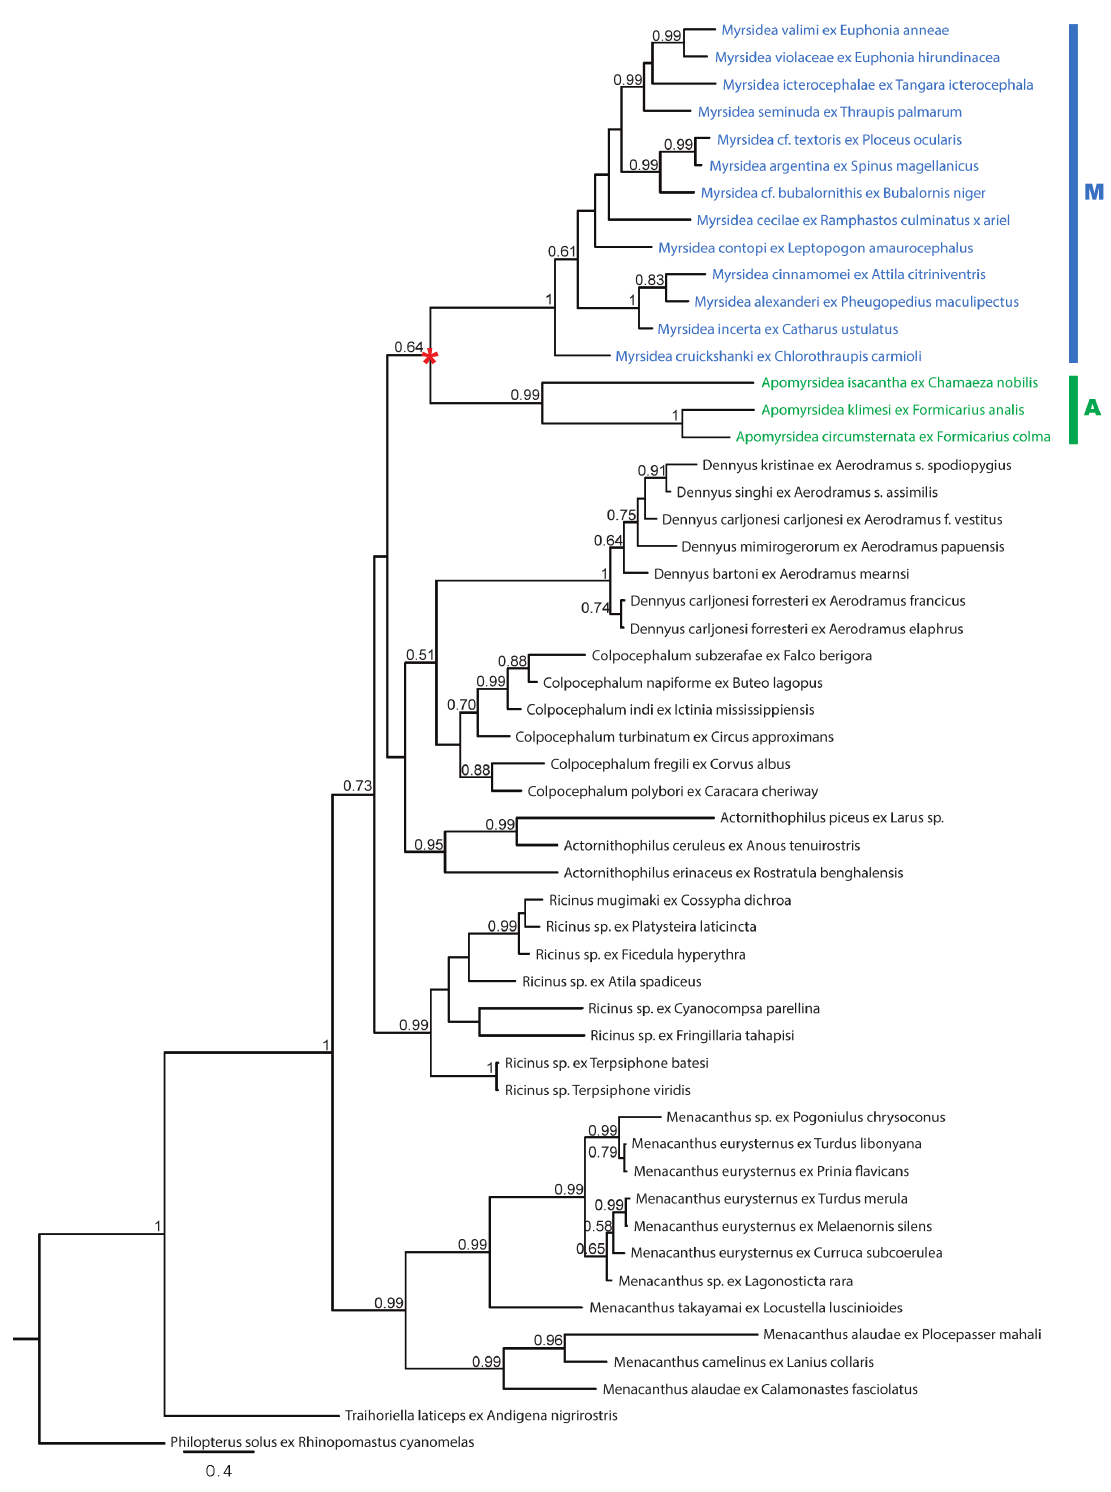
Fig. 10. Bayesian phylogenetic tree of selected amblyceran genera and species based on partial mitochondrial gene COI. Tree is rooted with outgroup species Philopterus solus (Tendeiro, 1962). Posterior probability values are shown above the nodes (values < 50% are not shown). Blue colour indicates species of Myrsidea Waterston, 1915 (M); green colour indicates species of Apomyrsidea gen. nov. (A); * symbol indicates a node between Myrsidea and Apomyrsidea